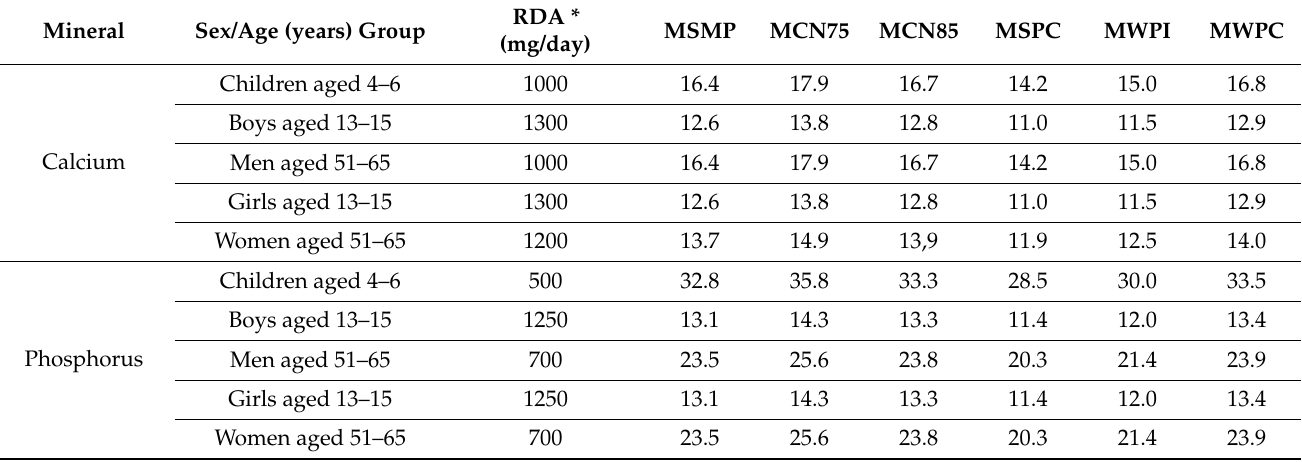
Table 3. Daily nutrient intake per 100 g of non-fermented milks enriched with protein preparations (%).